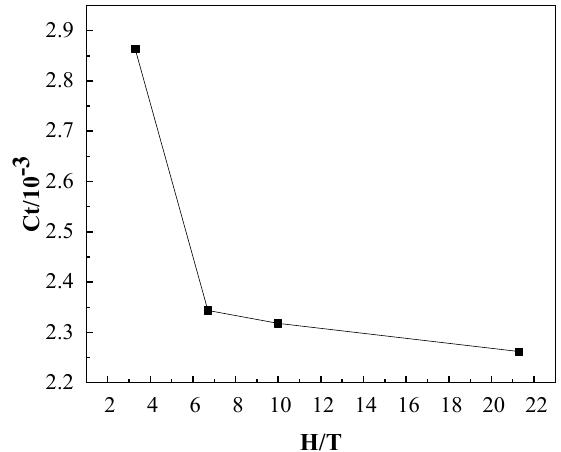
Figure 13. Total resistance coefficients of the full-scale KCS with different depth/draft ratios (H/T).